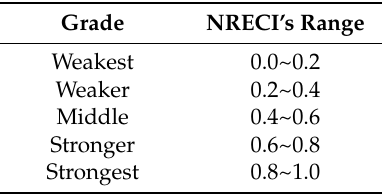
Table 4. Classification level based on the range of